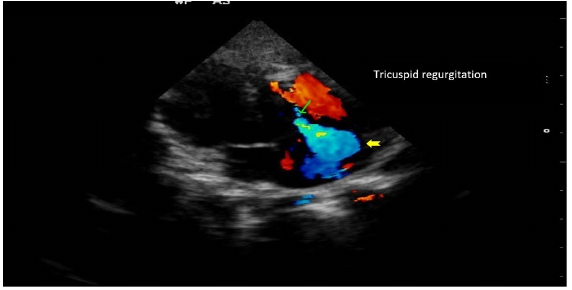
Figure 4. Doppler echocardiographic image, left parasternal window, four chamber apical section, to color Doppler study showing systolic turbulence inside the right atrium (arrow) indicating tricuspid valve regurgitation.